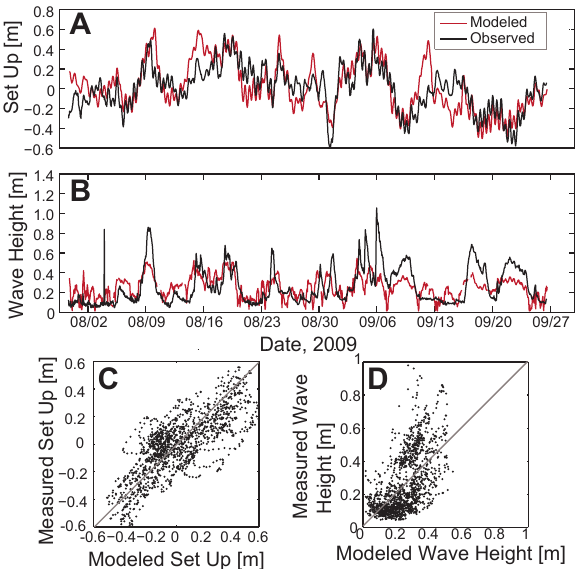
Figure 10. Measured and modeled setup and wave height for sum- mer 2009. Buoy was deployed in 2.2m water